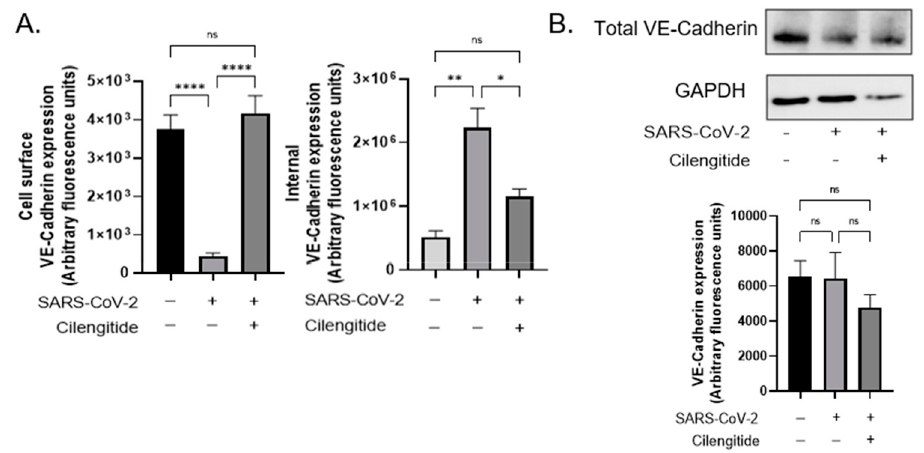
Figure 3. SARS-CoV-2 RGD motif triggers internalization of Vascular-Endothelial Cadherin. ( A ) Quantification of VE-Cadherin levels computed using ImageJ analysis, following background re- moval (* p < 0.05, ** p < 0.01, **** p < 0.0001, One-way ANOVA). ( B ) Western blot analysis performed on total VE-Cadherin expression in healthy and SARS-CoV-2 infected endothelial cells. Treated cells were incubated with 0.0005 µM Cilengitide for 1 h. Representative densitometry performed on Western blot (One-way ANOVA). Ns = not significant. Values are mean ± S.E.M., n = 3. 3.3. Targeting Intracellular Integrin Pathways Can Prevent Vascular Dysregulation Following Infection Focal adhesion kinase (FAK) and Proto-oncogene tyrosine-protein kinase Src (Src) are non-receptor tyrosine kinases that localize to the integrin β tail and are widely impli- cated in coordinating integrin signaling transduction in response to external stimuli such as adhering to an RGD ligand. Since these proteins regulate the RhoGTPases that control VE-Cadherin internalization, we investigated whether inhibiting these proteins associ- ated with the integrin could also encourage similar events of vascular barrier protection as the integrin antagonist. Inhibition of FAK and Src prevented endothelial hyperperme- ability in response to SARS-CoV-2 infection over 24 h. Furthermore, this reduction was comparable to Cilengitide (Figure 4A). Figure 4. Vascular permeability induced by SARS-CoV-2 infection is mediated by endothelial integ- rin α V β 3. ( A ) Pharmacological inhibitors of Src (SU6656, 1 µM), FAK (PF562271, 1 µM), and integrin α V β 3 (Cilengitide, 0.0005 µM) incubated with SARS-CoV-2 infected endothelial cells. **** p < 0.0001****, One-way ANOVA. Values are mean ± S.E.M., n = 3. ( B ) Schematic depiction of the pro- posed pathway of integrin engagement with spike protein and subsequent signaling cascade lead- ing to the disease phenotype of hyperpermeability. Top panel portrays a healthy endothelial cell,